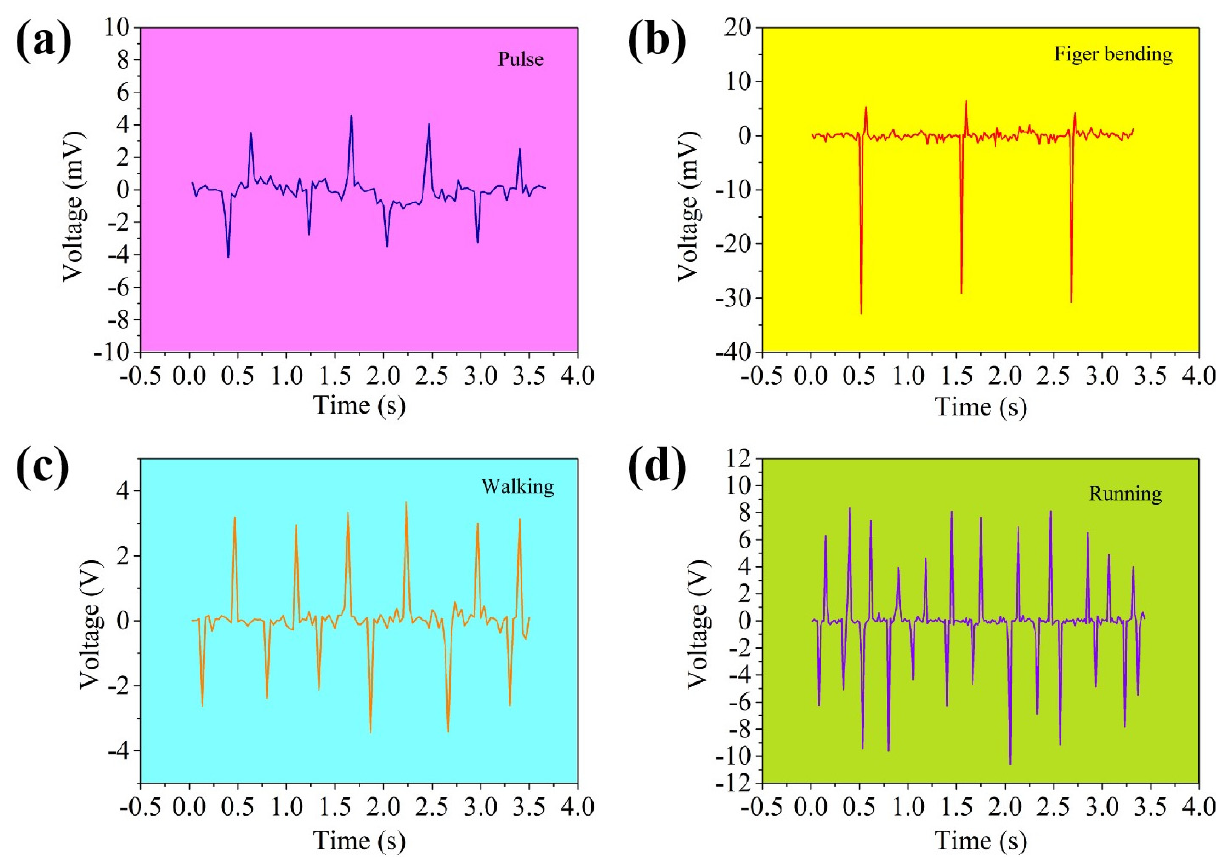
Figure 7. Wearable nanogenerator based on TENG at 25 °C: ( a ) placed on the wrist for weak pulse signals, ( b ) placed on the index knuckle to bend and clench and ( c , d ) placed on the sole of the foot to walk and run to generate energy.